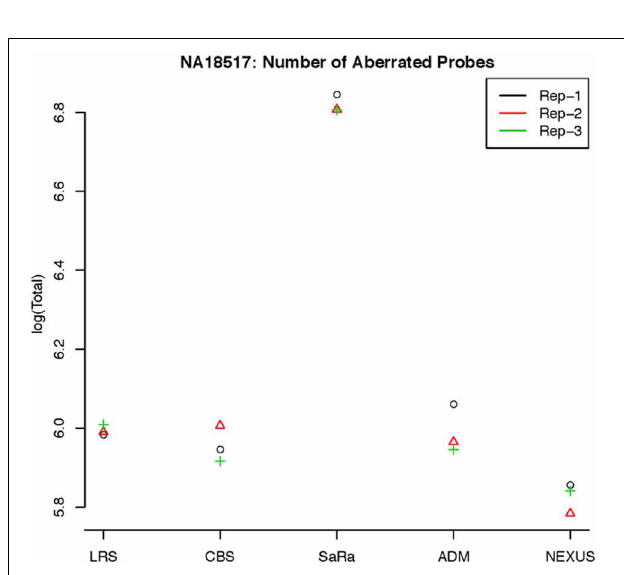
FIGURE 6 | log(Number) of unique CNV identified by each algorithm for HapMap sample NA12239 for each technical replicate. larger than the scan width of 100 chosen for LRS. This suggests the need to use a global algorithm in conjunction with LRS to obtain accurate break point detection for larger regions. Both